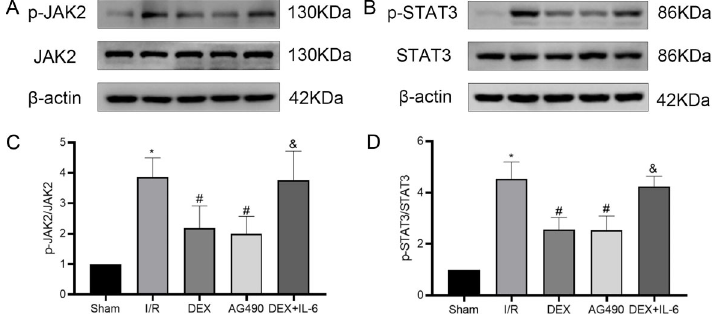
Figure 6. The protein levels of p-JAK2/JAK2 and p-STAT3/STAT3 were detected by western blotting. Representative western blots for A , JAK2 and p-JAK2, and B , STAT3 and p-STAT3. Densitometry analysis of western blots for the C , p-JAK2/JAK2 ratio, and D , p-STAT3/ STAT3 ratio. Data are reported as means ± SD, n=5. *P o 0.05 vs Sham group; # P o 0.05 vs I/R group; & P o 0.05 vs DEX group (one-way ANOVA). I/R: ischemia/reperfusion; DEX: dexmedetomidine; IL-6: interleukin-6.